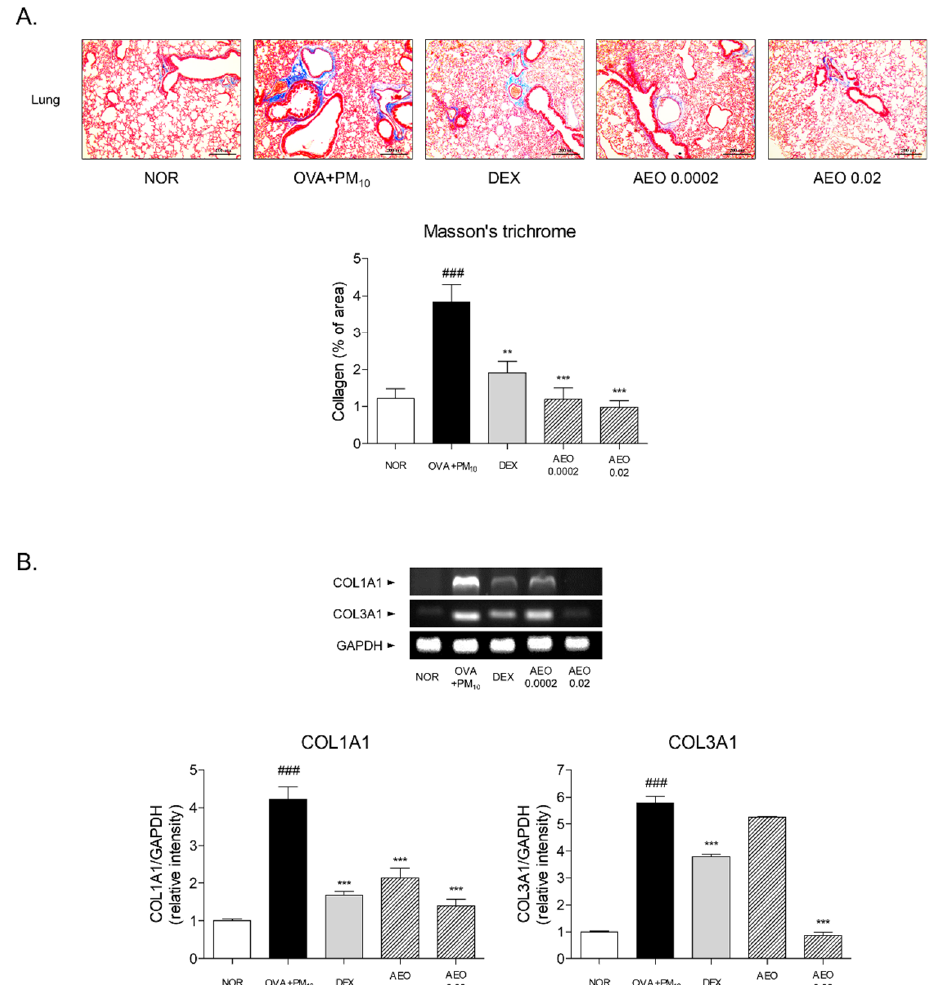
Figure 4. Collagen deposition % of area of lung tissues. ( A ) Lung tissues stained by Masson’s trichrome. Blue-stained area of lung tissues indicates collagen accumulation. Magnification is × 100. Results are presented as mean ± standard error of the mean. ### p < 0.001 vs. NOR group; ** p < 0.01 and *** p < 0.001 vs. OVA+PM 10 group. ( B ) Expressions of COL1A1, COL3A1 mRNA levels in lung tissues. Results are presented as mean ± standard error of the mean. ### p < 0.001 vs. NOR group; *** p < 0.001 vs. OVA+PM 10 group.